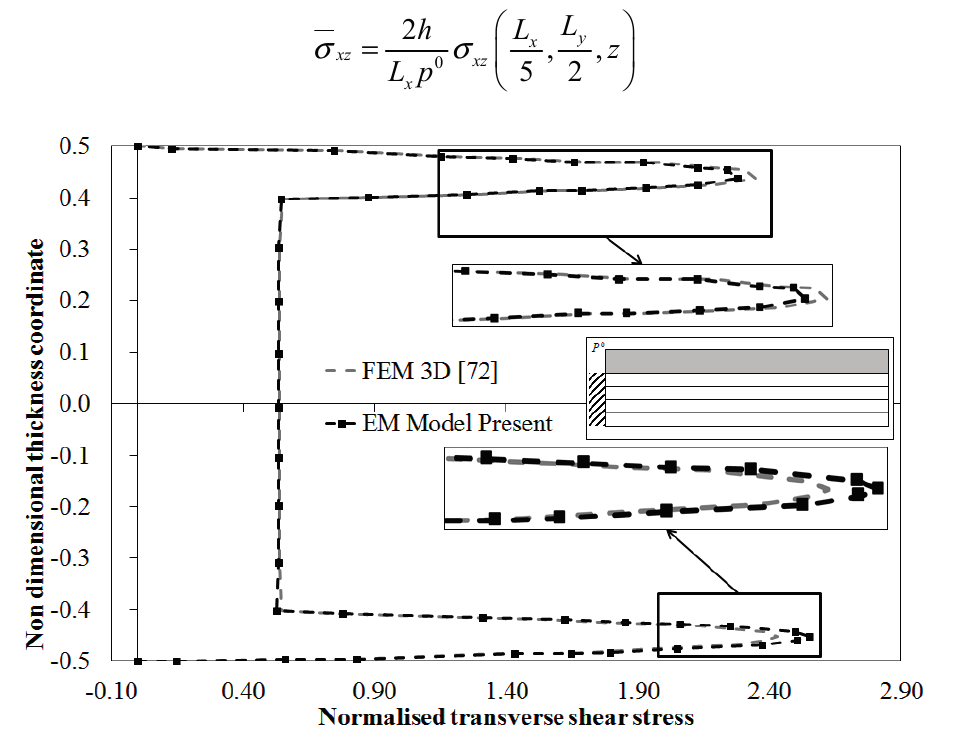
Figure 6. Normalized transverse shear stress by the present EM Model and by the 3D FEM [72] for a cantilever